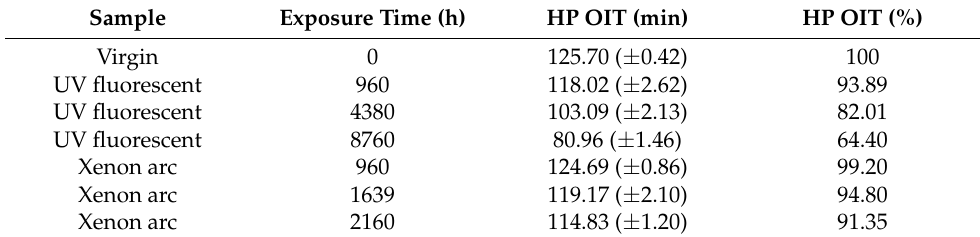
Table 5. HP OIT test results after UV laboratory exposures.